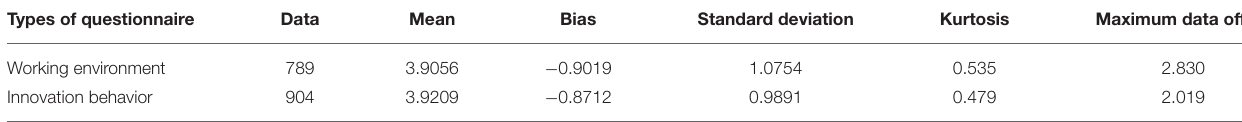
TABLE 3 | Average characteristics of questionnaire data.